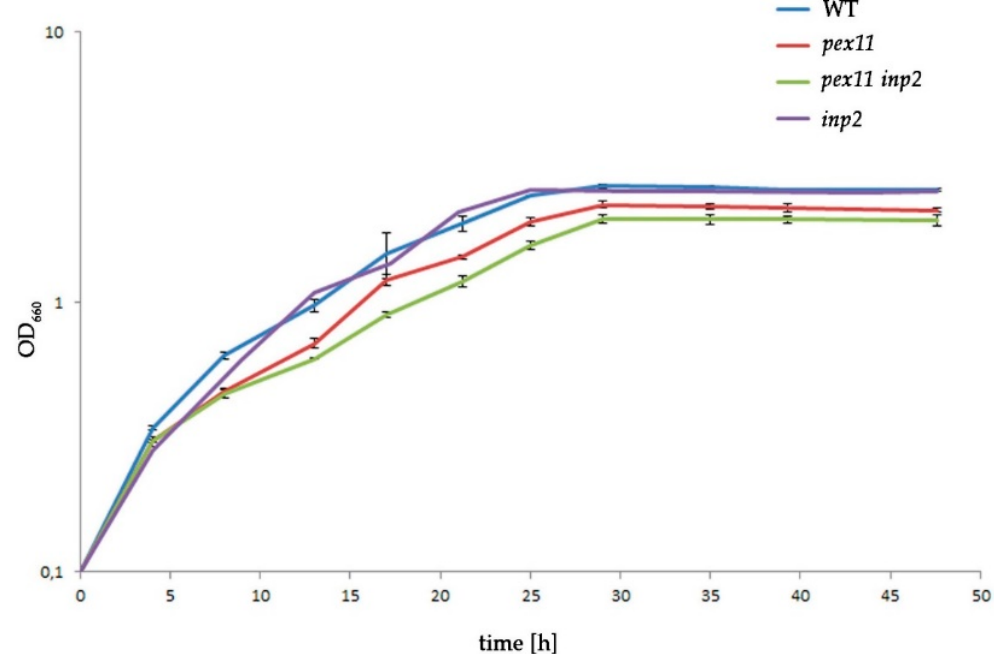
Figure 6. Impaired fission and inheritance affect growth of H. polymorpha cells. Growth curves of H. polymorpha WT, pex11 , pex11 inp2 and inp2 . Cells were pre-cultivated on glucose medium and shifted